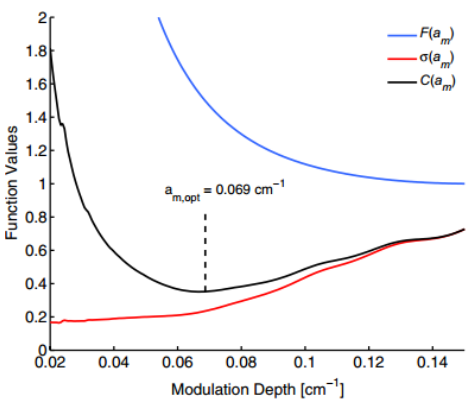
Figure 10. Inverse WMS-2 f signal strength (F, blue line), NH 3 interference sensitivity ( σ , red line), and cost function ( C , red line) vs modulation depth for a 3 ppm NH 3 mixture in CH 4 − air ϕ = 0.6 combustion exhaust at T = 600 K, P = 1 atm . The optimal modulation depth 𝑎 𝑚,𝑜𝑝𝑡 is shown in the black/dashed line. Figure adapted from [96].